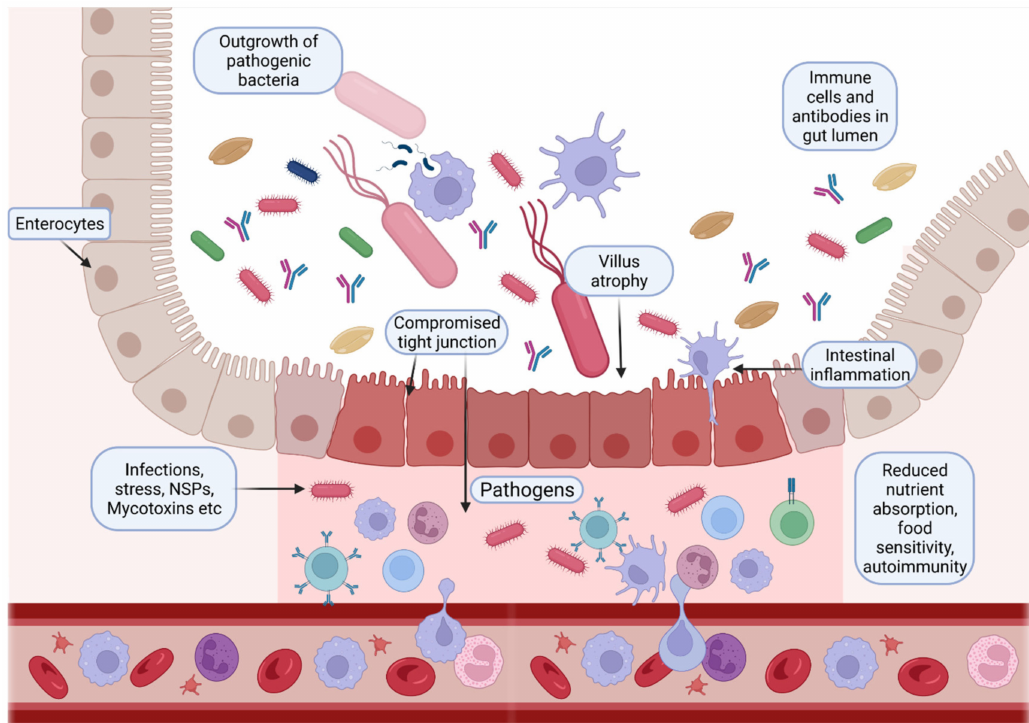
Figure 2. Dysbiosis induced by different factors alters the gastrointestinal homeostasis causing impaired epithelial barrier function and systemic inflammation. Created with BioRender.com (26 March